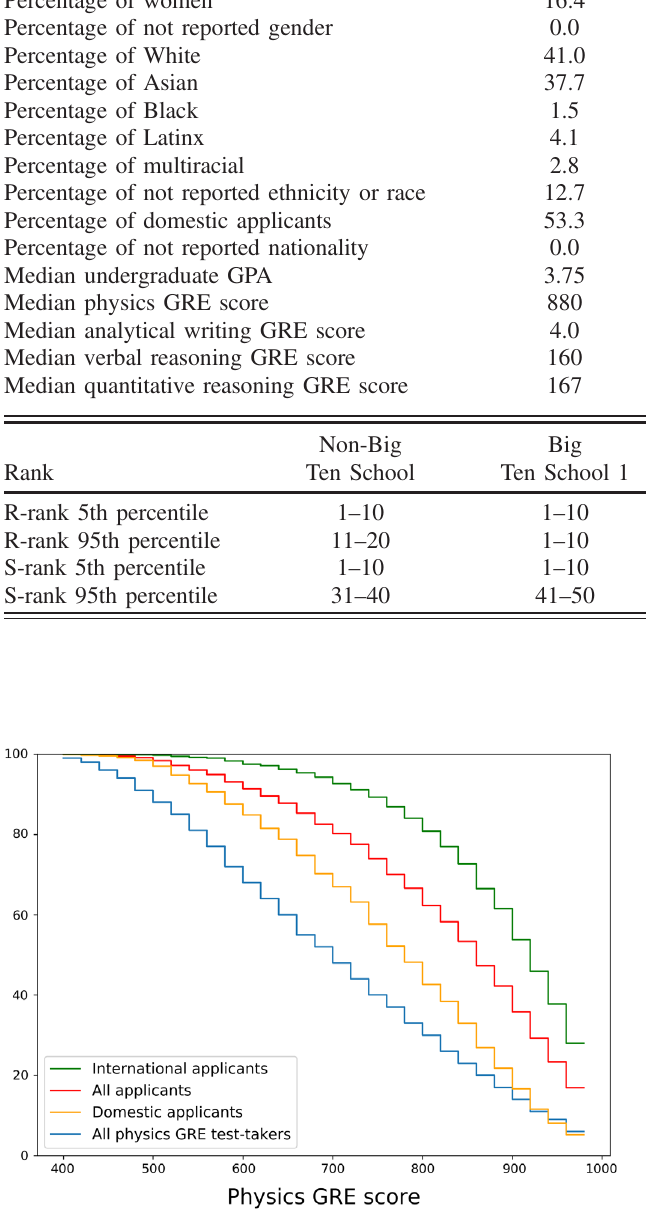
FIG. 1. A comparison of the P-GRE distribution between national data [22] and data used in this study. The analysis is primarily concerned with domestic applicants (yellow